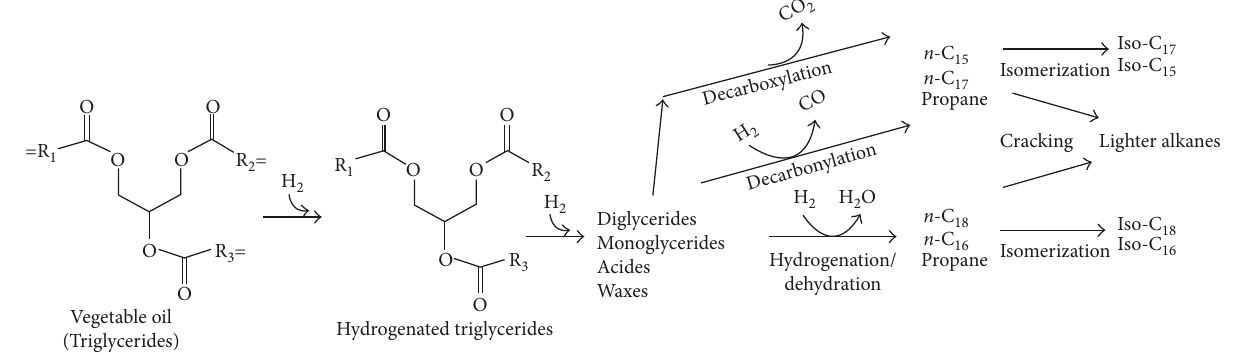
Figure 1: Reaction pathway for conversion of triglycerides to alkanes Table 1: Measured properties of the baseline ULSD and HUCO fuels.